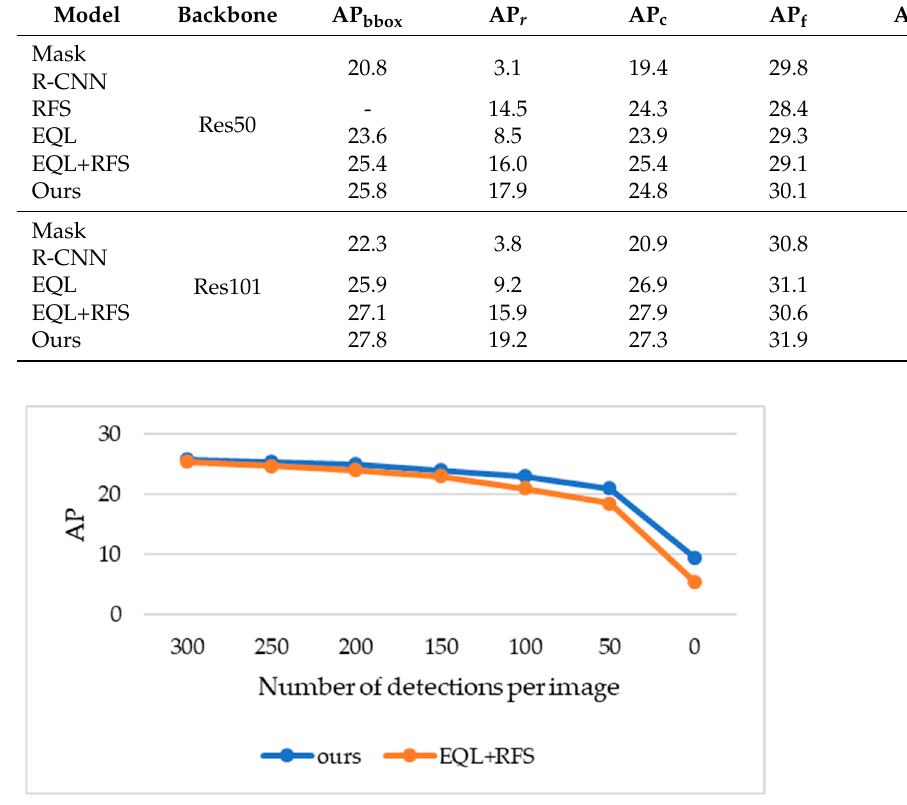
Figure 7. AP with different number of image detections.